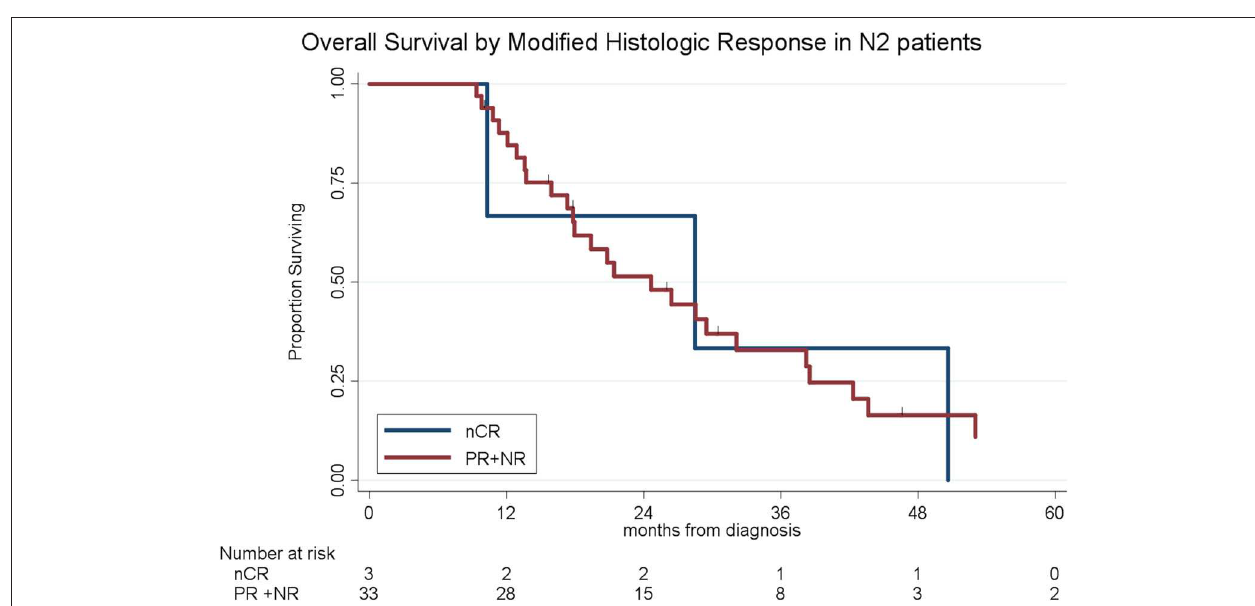
FIGURE 6 | Overall survival by modified histopathologic response among N2 patients.